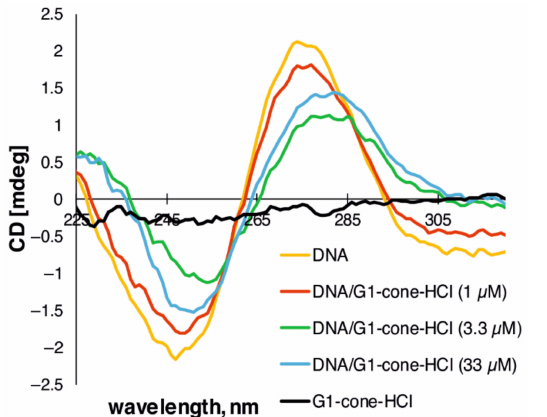
Figure 5. CD spectra of DNA (1.855 × 10 − 5 M base pairs) in the presence of various concentrations of G1-cone-HCl